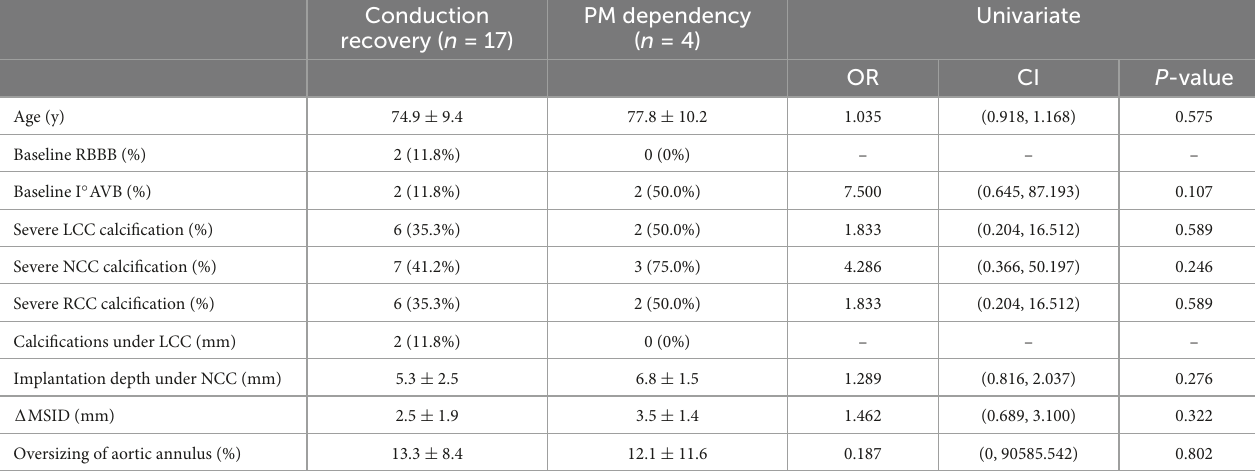
TABLE 5 Univariate analysis of predictors of conduction recovery after transcatheter aortic valve replacement